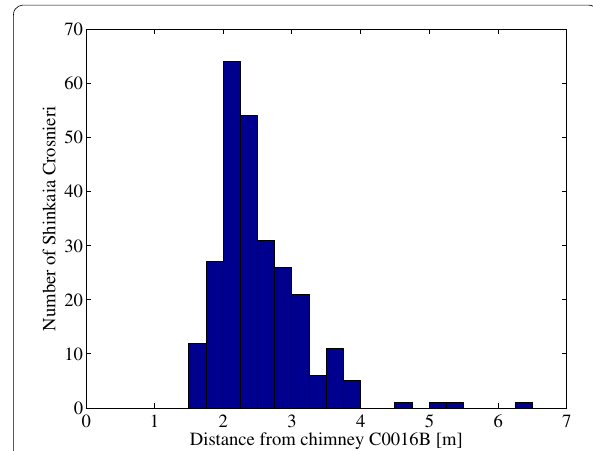
Fig. 10 Histogram showing the relationship between the number of S. crosnieri and the radial distance from the chimney mouth of chimney C0016B